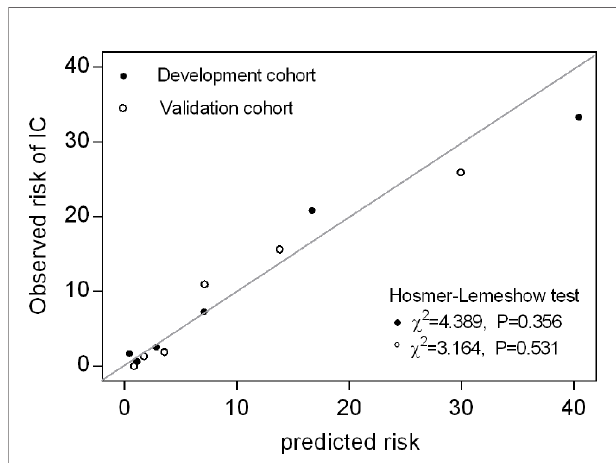
TABLE 3 | Distribution of the risk scores strati fi ed by IC diagnosis in the development cohort. Predictive score value